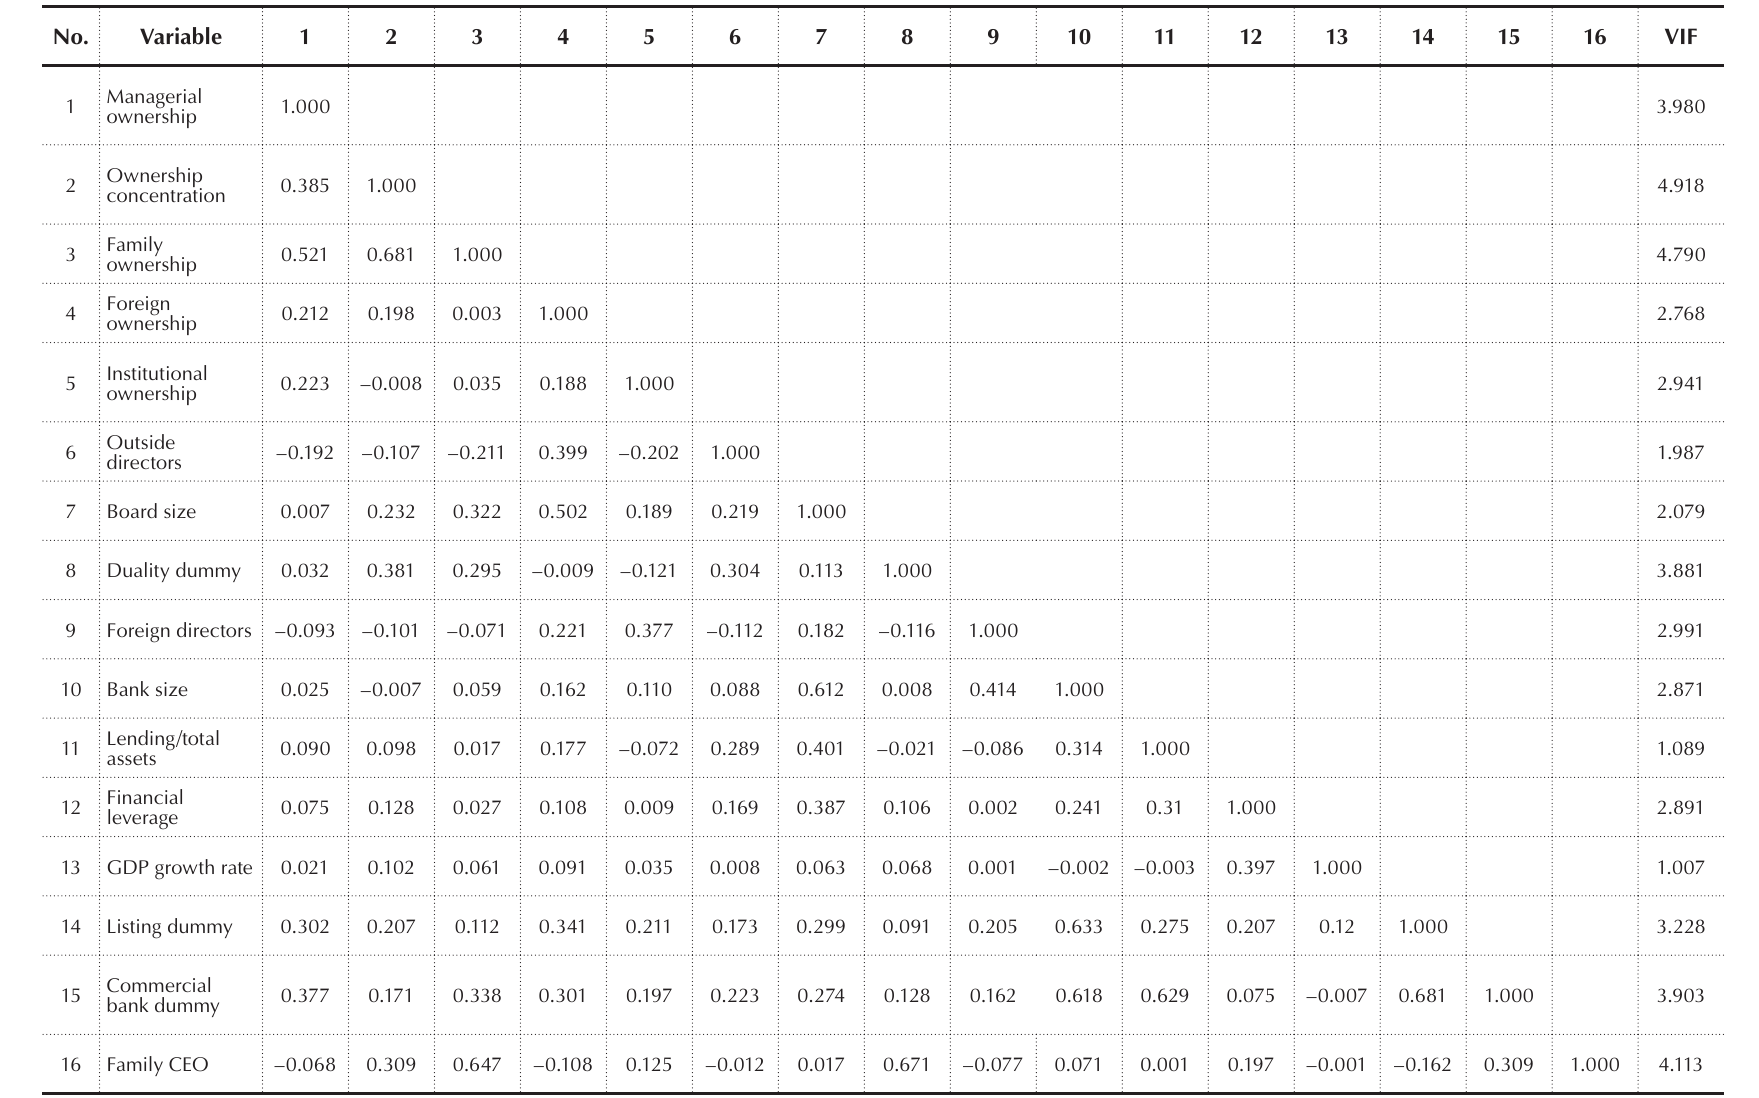
Table (cid:1006). (cid:18)(cid:381)(cid:396)(cid:396)(cid:286)(cid:367)(cid:258)(cid:415)(cid:381)(cid:374)(cid:3)(cid:373)(cid:258)(cid:410)(cid:396)(cid:349)(cid:454)